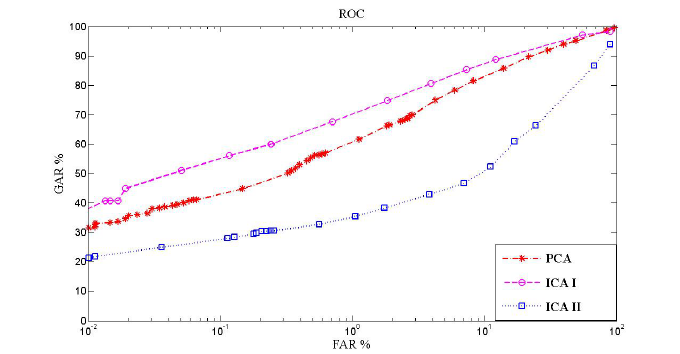
Figure 5. ROC curves for conventional methods on Database I.